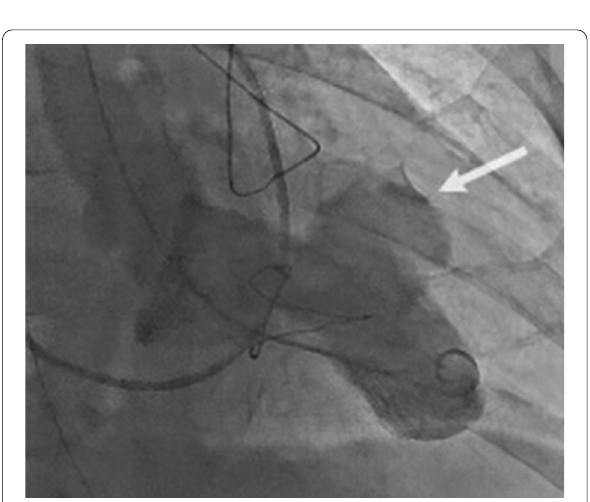
Fig. 2 Left ventriculogram revealing a saccular aneurysm-like protrusion at the ventricular septum (white